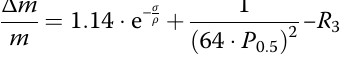
Figure 7 presented the comparison between the test results and prediction results obtained from Eq. (2) to (4). It can be seen that the proposed models showed similar results to development of the SCGAAC experi- enced water absorption and freeze-thaw cycles.